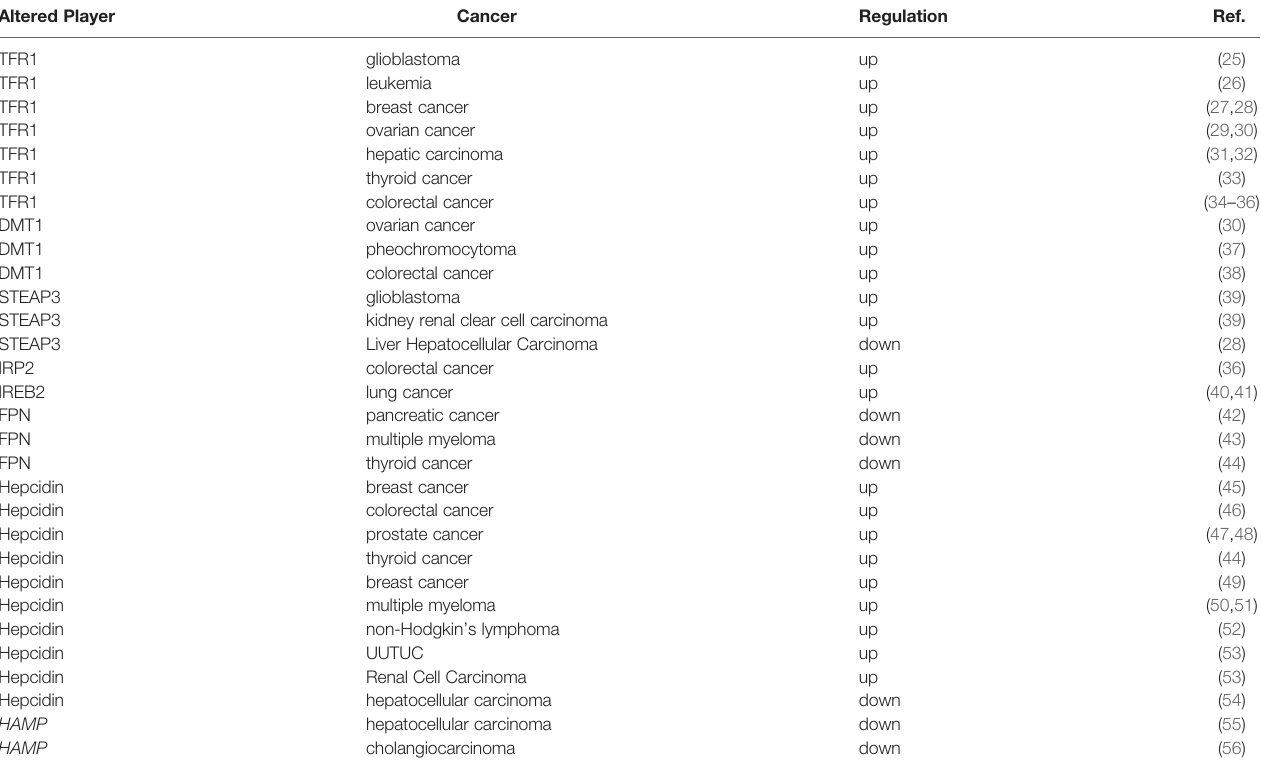
TABLE 1 | Iron regulators in